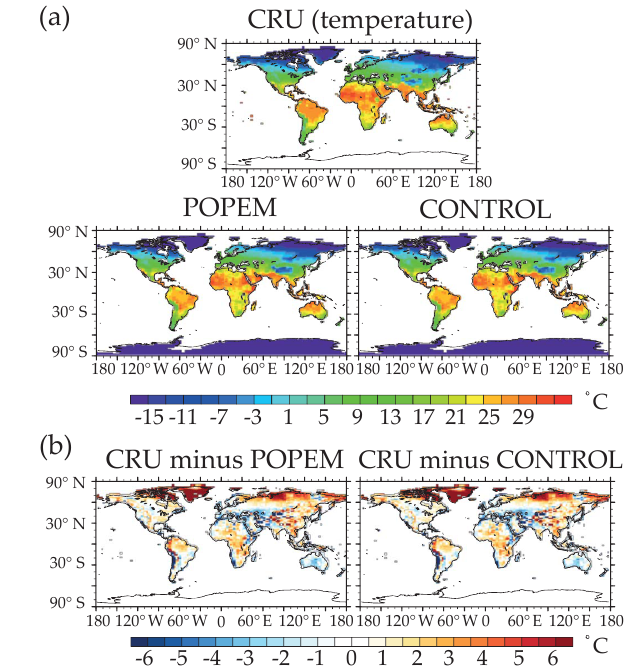
Figure 10. A comparison of the annual mean temperature (1950– 2000) as simulated by the CESM model (POPEM and CONTROL) and CRU observational database. (a) Global annual mean tempera- ture maps for CRU, POPEM, and CONTROL. (b) Absolute differ- ence maps. Units are in ◦ C.